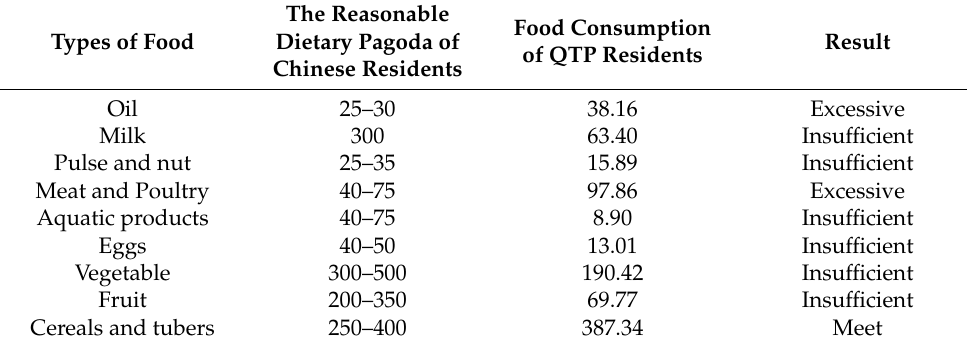
Table 1. Comparison with the dietary pagoda of Chinese